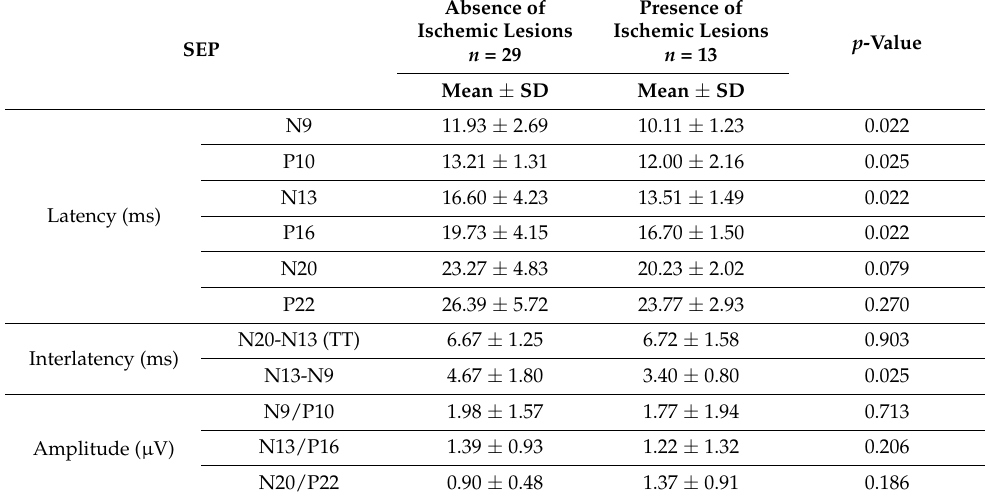
Absence of Presence of Ischemic Lesions Ischemic n = 29